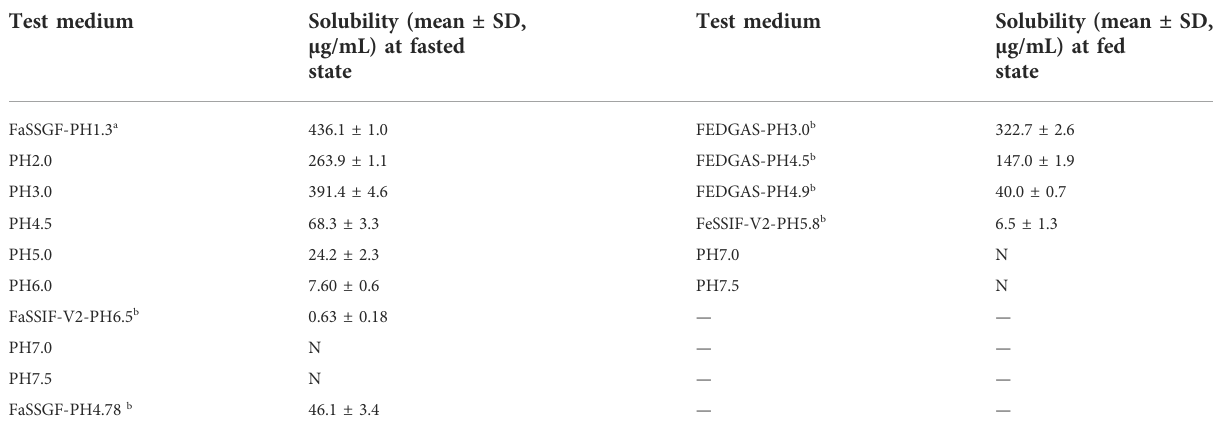
TABLE 1 pH-solubility at fasted/fed state. Test